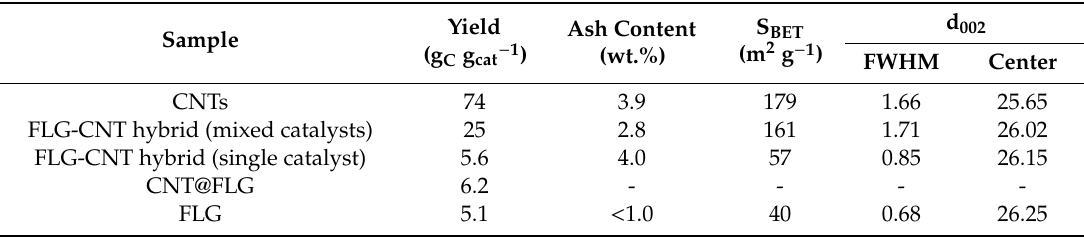
Table 2. Yield, ash content determined by TGA, Brunauer–Emmett–Teller (BET) specific surface area calculated from N 2 adsorption-desorption at − 196 ◦ C, and d 002 peak parameters from XRD for purified CNTs, FLG–CNT hybrids, and FLG.